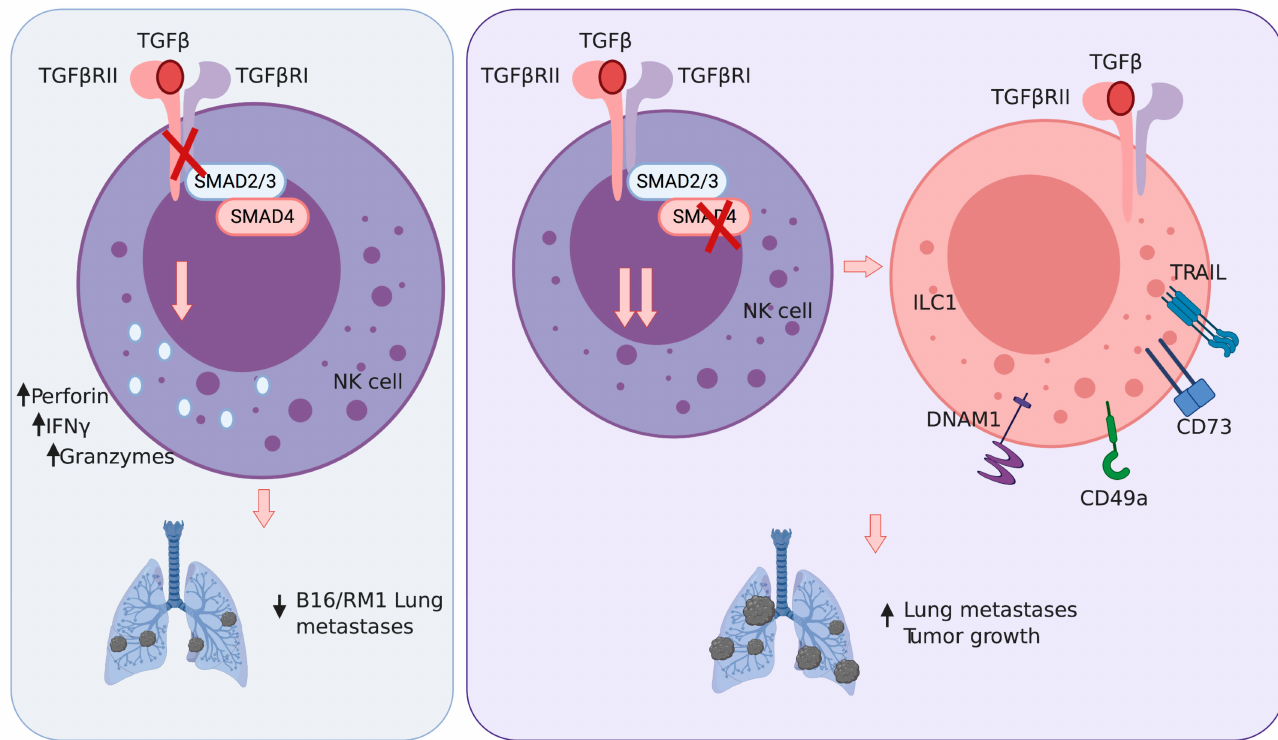
Figure 1. Impact of TGF β signaling in NK cells/ILC1s in tumors. Left panel: TGF β signaling blockade promotes NK cell activation (perforin, granzymes, IFN γ production) in vitro and lung metastases control in vivo. Right panel: SMAD4 genetic blockade results in a more pronounced ILC1 phenotype, and this is associated with reduced tumor control in vivo. Whether this is due to a reduced NK cell anti-tumor activity or a more prominent ILC1 phenotype is still to be